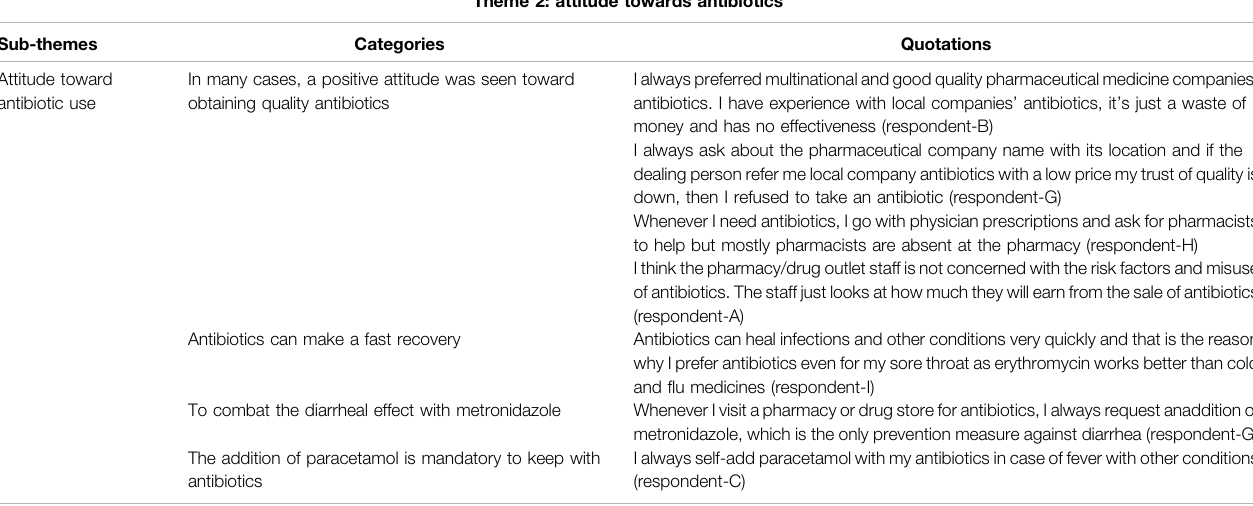
TABLE 4 | Participants ’ attitude towards